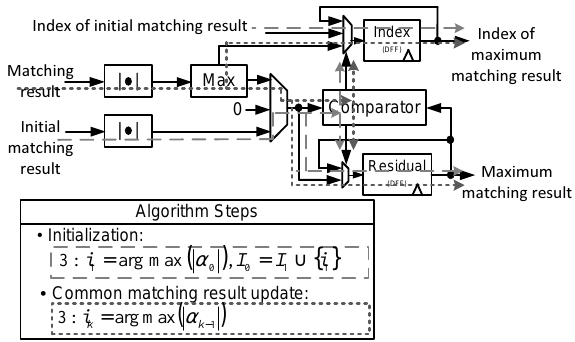
Figure 12. Data path of index selection circuit.